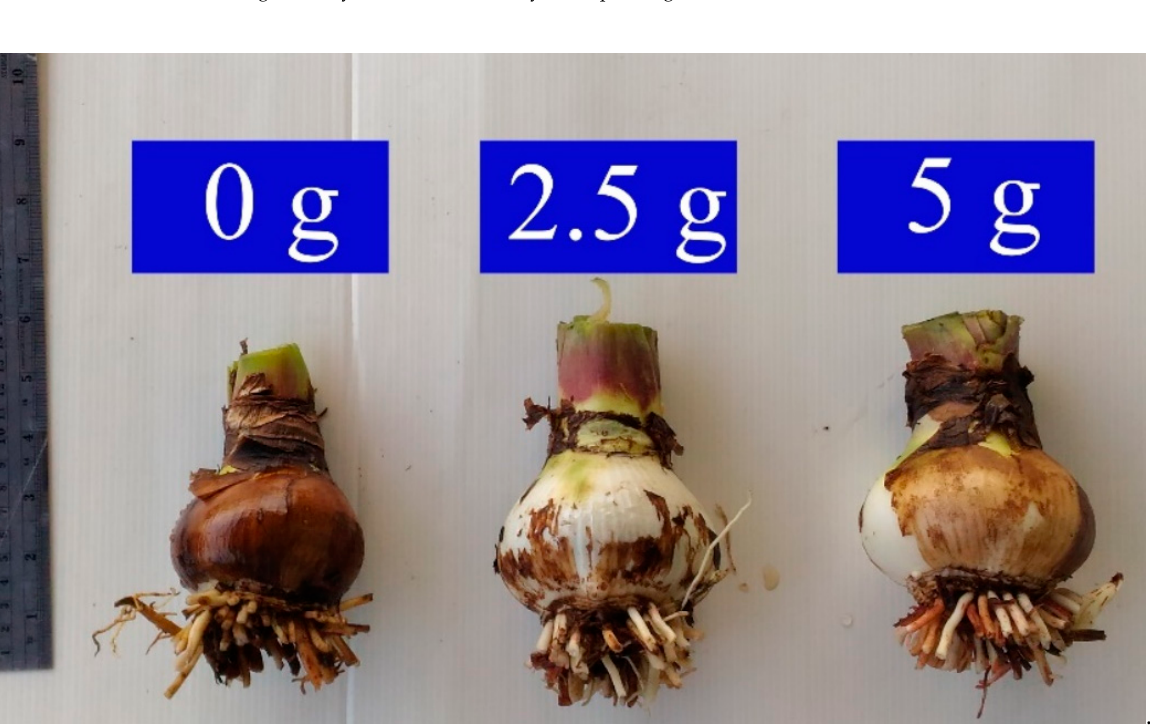
Figure 2. Bulb quality of Hippeastrum ‘Red Lion’ after fertilization at different rates 180 days after planting.